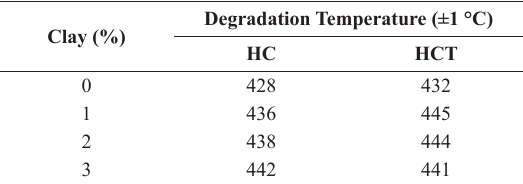
Table 1. TG degradation data for the samples prepared with chloroform (HC) and chloroform/toluene (HCT). Clay (%)